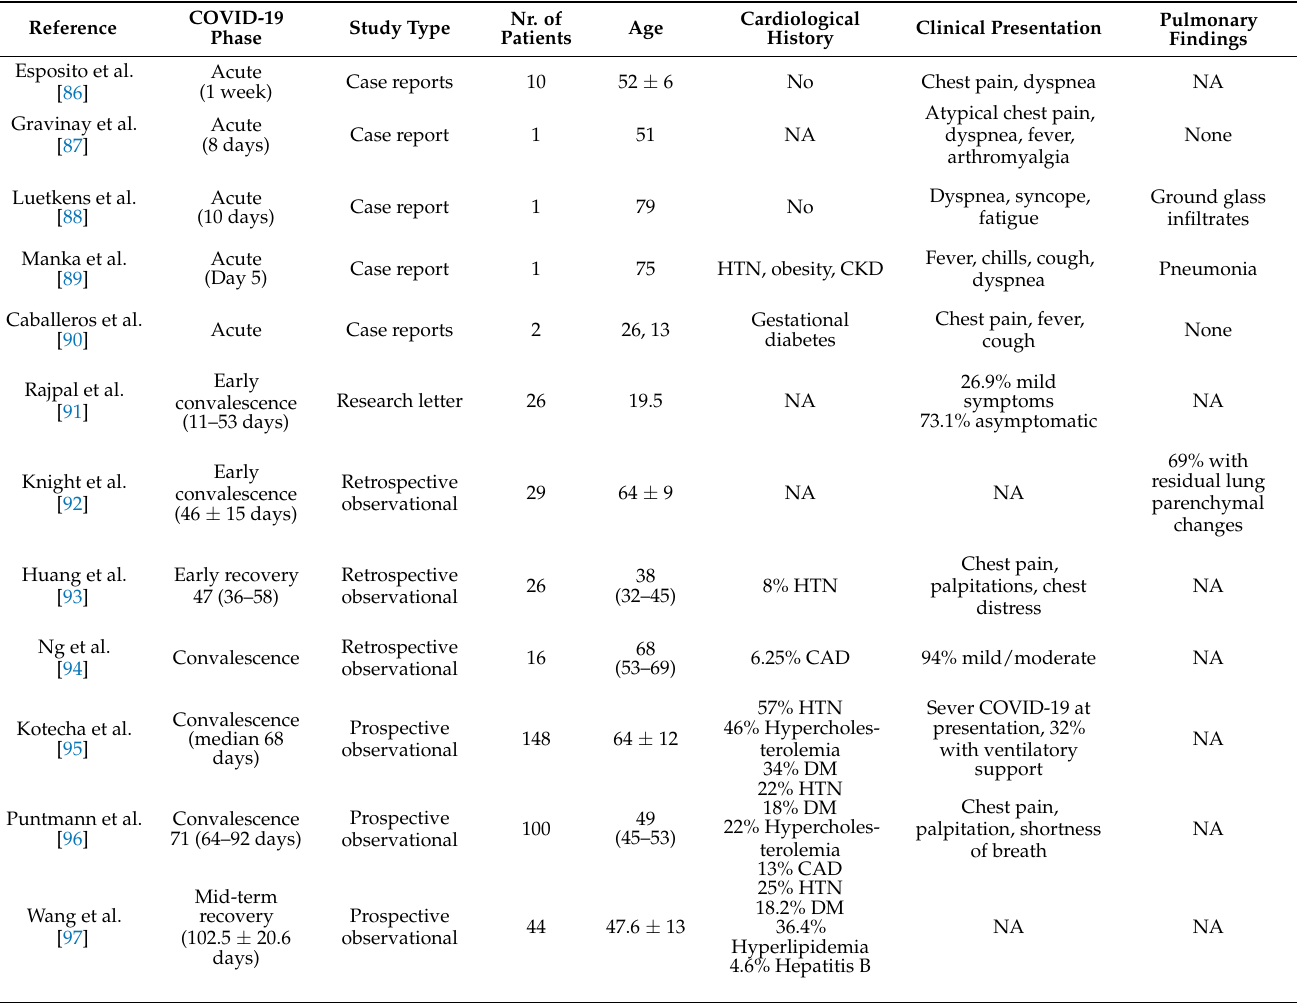
Table 1. General characteristics of the main studies on cardiac involvement in